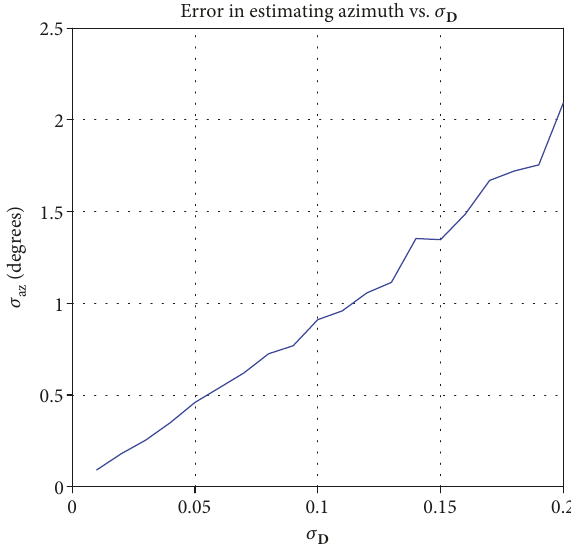
Figure 2: The error in estimating D as function of the number of periods P , for different signal-to-noise ratios. Known DOAs, K = 2 signals per period, N = 100 snapshots, averaged over 100 noise realizations.